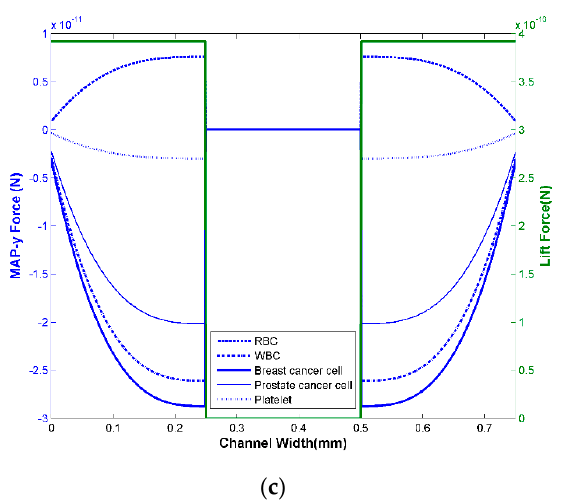
Figure 13. Plot of cell trajectories in the presence of MAP for ( a ) RBCs and ( b ) other nucleated blood cells (WBCs, platelets, and CTCs). The colour spectrum bar indicates the magnetic susceptibilities of cells, as such RBCs are represented by red particles while other nucleated cells are blue. The cell motion was explained through the graph of calculated y-directional magnetic and hydrodynamic forces as illustrated in ( c ). Zero forces were found in the region bounded by x = 0.25 and x = 0.5 due to the presence of inbuilt ferromagnetic track, which was simulated to have the same height as the microchannel.